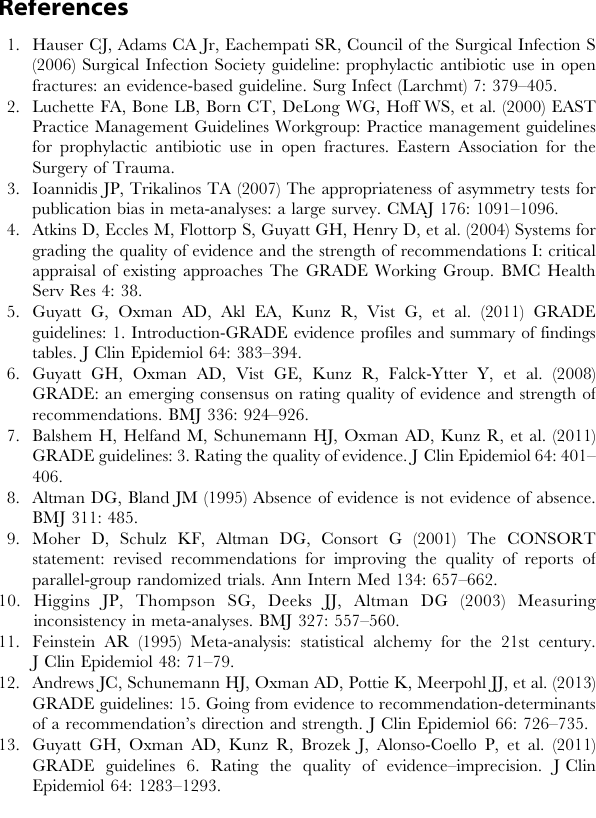
illustrating the literature selection process, and Table S4 illustrating evidence assessment for the fourth query. illustrating the literature selection process, and Table S5 illustrating evidence assessment for antibiotic-resis- tant bacteria (undesirable